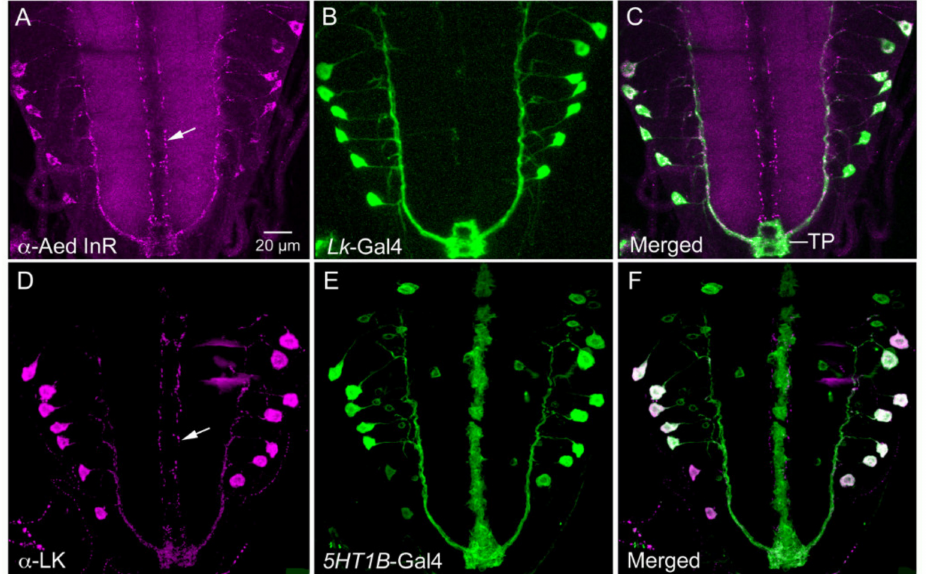
Figure 7. LK-expressing neurons, ABLKs, in the Drosophila larva co-express receptors of insulin and serotonin. ( A – C ) Antiserum to Aedes aegypti insulin receptor (Aed InR) labels Lk -Gal4 expressing ABLKs and axons of SELKs (arrow). ( D – F ) LK antiserum labels ABLKs that also express 5HT1B-Gal4 (serotonin receptor 1B). Note that SELK axons (arrow) do not express 5HT1B receptor Gal4. A is from [96] and B from [100], with permission from the